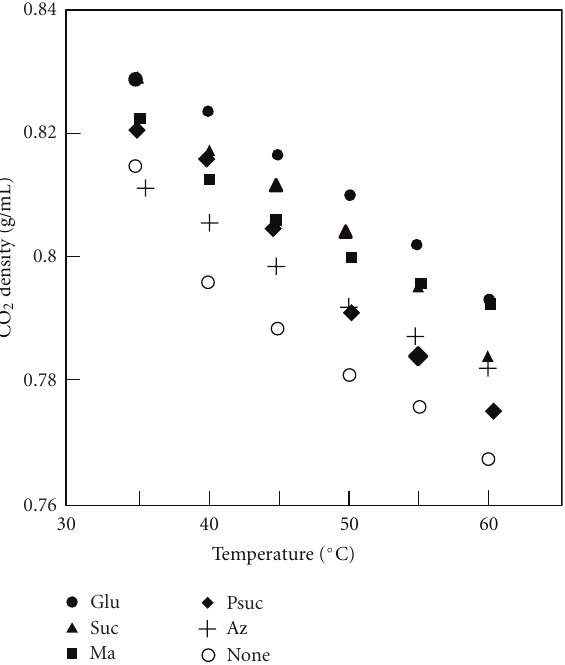
Figure 16: Plots of the experimental cloud points of the P(POA- r - DAA) copolymer in the presence of the dicarboxylic acids at each temperature. The acid/DAA =